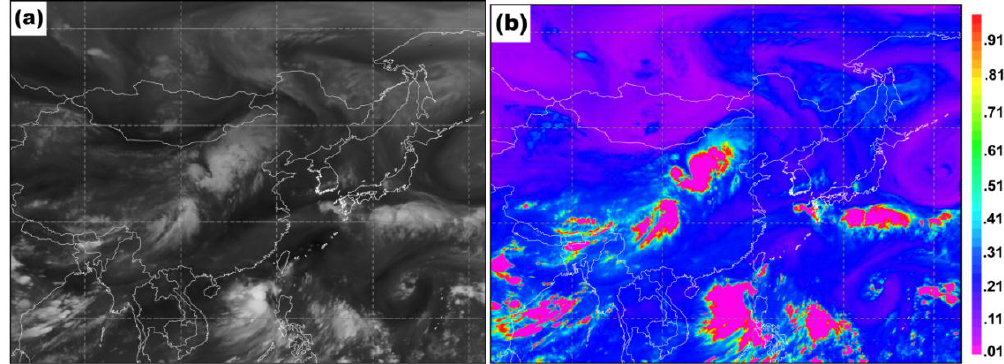
Figure 1 . ( a ) FY2E Water Vapor (WV) channel image at 0000UTC 21 July 2012; ( b ) the corresponding retrieval specific humidity at upper troposphere (g ∙ kg −1 ).